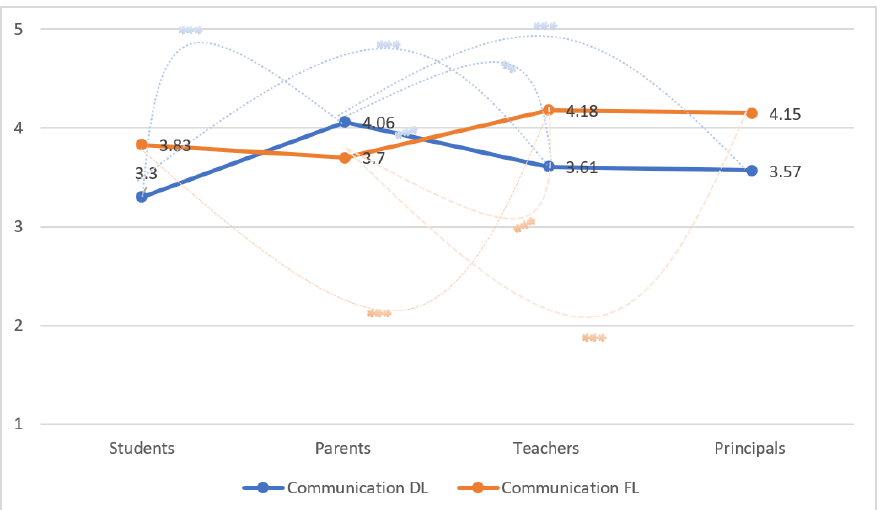
Figure 1. Communication Index (Distance Learning and Frontal Learning) according to the four stakeholders (Students, Parents, Teachers, Principals). Note: F = 72.54, p < 0.001 for differences for distance and frontal learning according to stakeholder as a result of repeated measure test. Statistical significance denoted as * ( p -value less than 0.05 (*); p -value less than 0.01 (**), p -value less than 0.001 (***) according to Bonferroni’s multiple comparisons test.